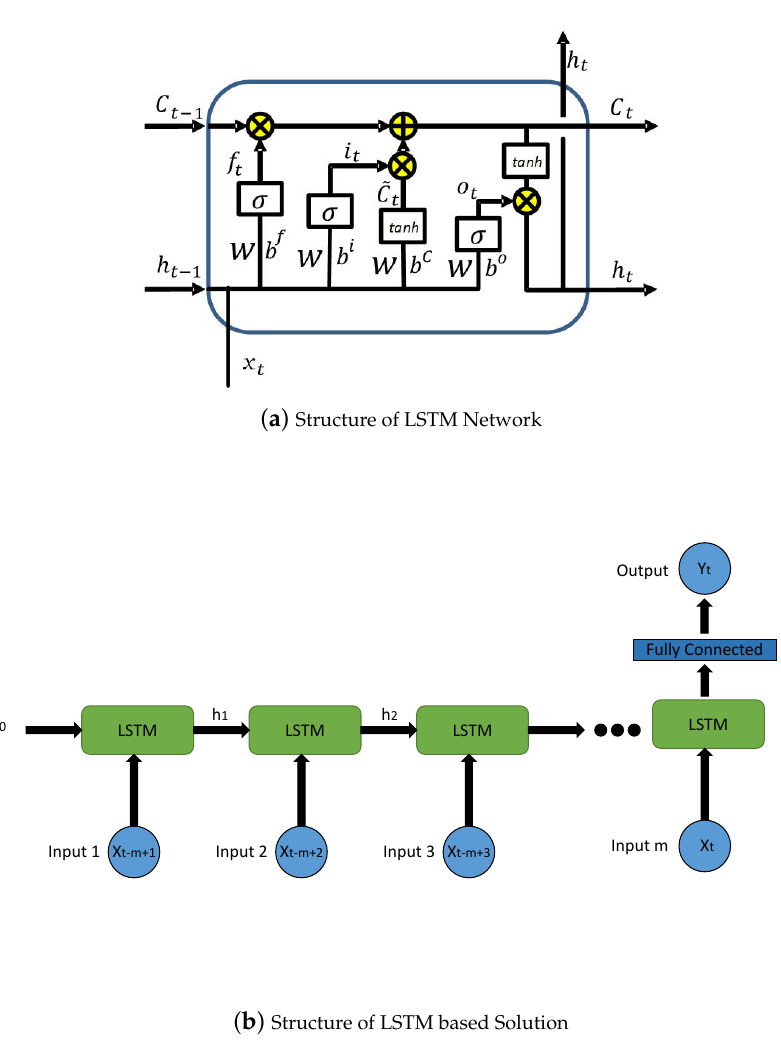
Figure 3. Structure of the LSTM network, and the LSTM based